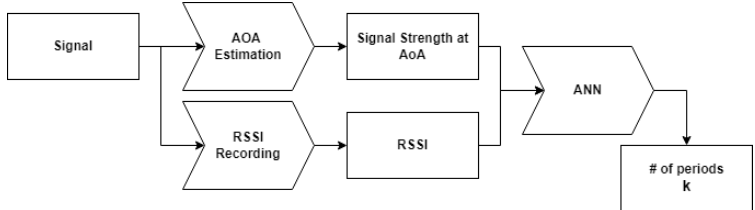
Figure 1. Workflow of the proposed